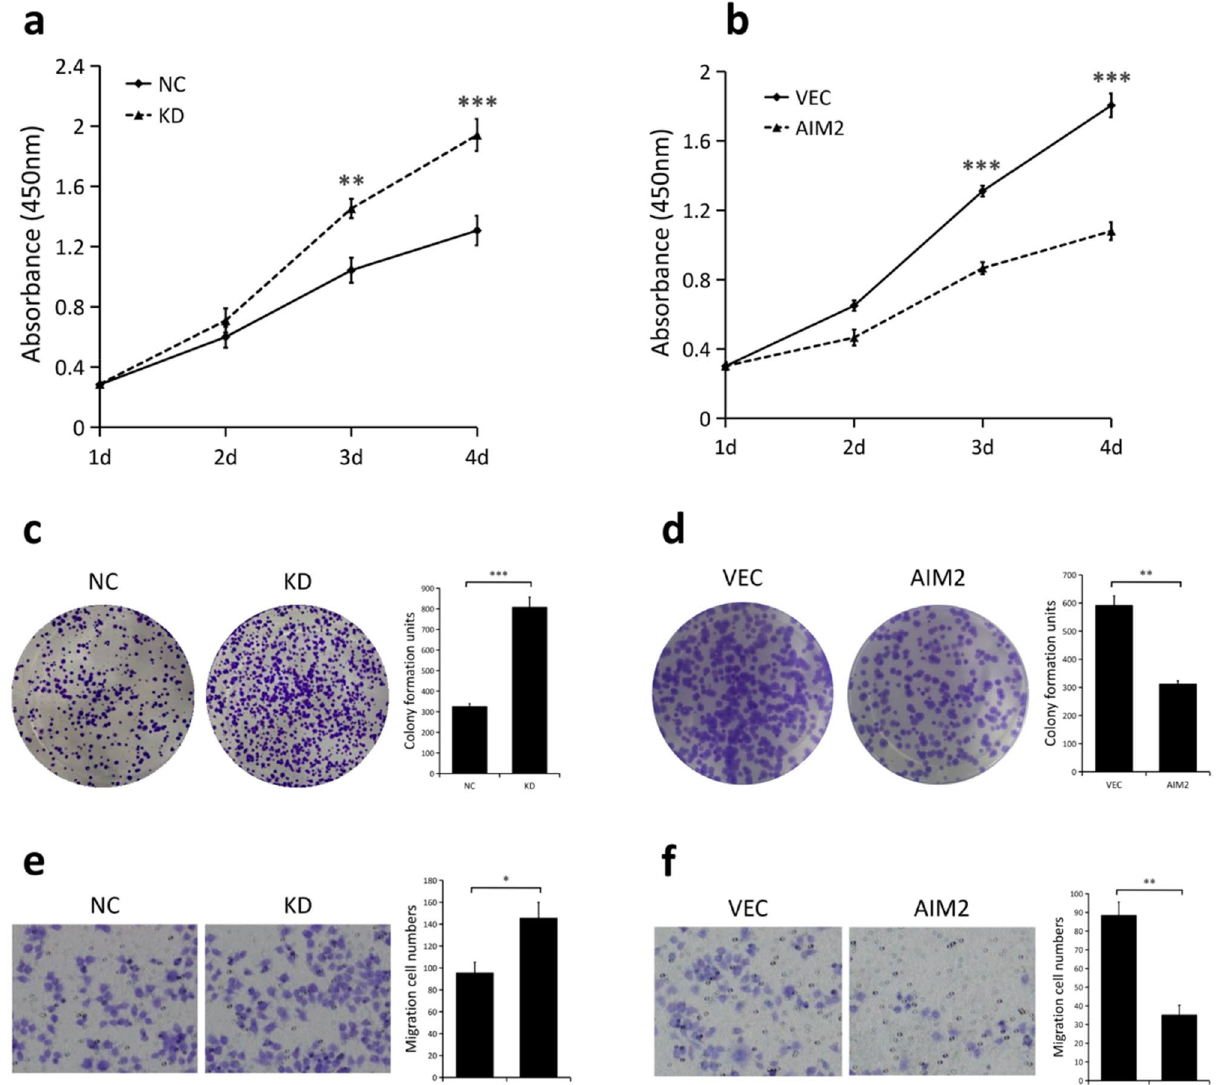
Figure 3. Effects of AIM2 on GC cell proliferation and migration. ( a ) CCK8 assays were performed in wild- type AGS cells (NC) and in cells with stable knockdown of AIM2 (KD). ( b ) CCK8 assays were performed in wild-type SGC7901 cells (VEC) and in cells with stable overexpression of AIM2 (OE). ( c ) Colony formation assays were performed in AGS cells (NC vs. KD) and the relative number of colonies was quantified (right). Error bars, mean ± SEM from three biological replicates. ( d ) Colony formation assays were performed in SGC7901 cells (VEC vs. OE) and the relative number of colonies was quantified (right). Error bars, mean ± SEM from three biological replicates. ( e ) Migration assays were performed in AGS cells (NC vs. KD), and the migratory cells number was quantified (right). Error bars, mean ± SEM from three biological replicates. f Migration assays were performed in SGC7901 cells (VEC vs. OE), and the migratory cells number was quantified (right). Error bars, mean ± SEM from three biological replicates. Statistical significance was analyzed by a two-tailed, unpaired Student t-test. * P < 0.05; ** P < 0.01; *** P <